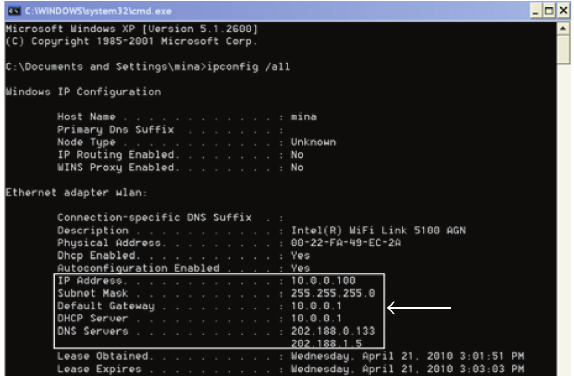
Figure 5: Console application at the victim side to verify the network configuration.